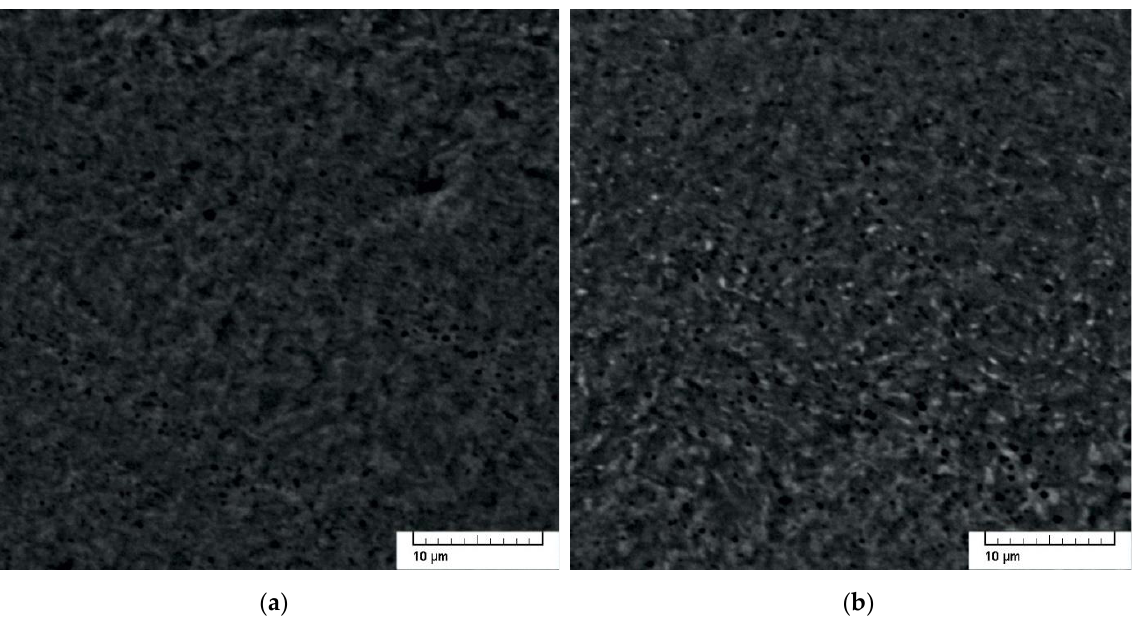
Figure 7. Images of the sample cross-section in the laser-processed area: ( a ) the fine-dispersed structure of low-carbon martensite in the remelting zone; ( b ) small grains of formed ferrite in the center of the weld.